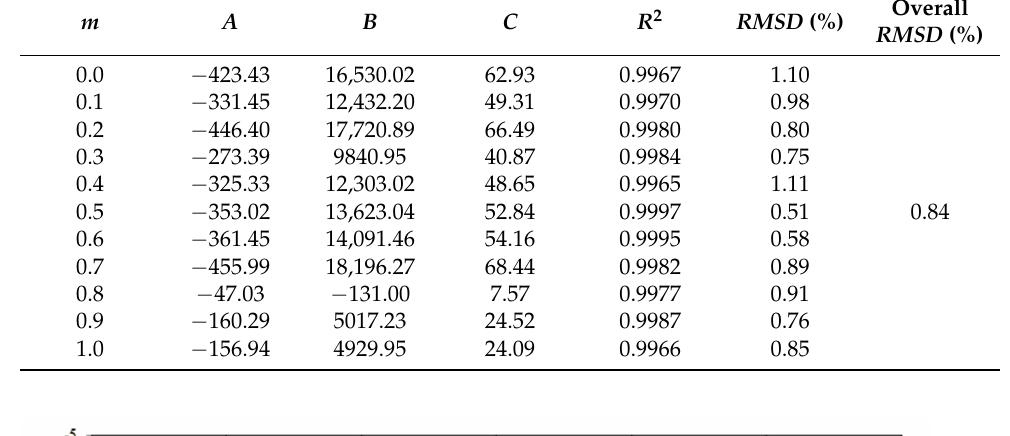
Table 6. Resulting data of modified Apelblat model for TQ in binary (IPA + H 2 O) compositions ( m ).